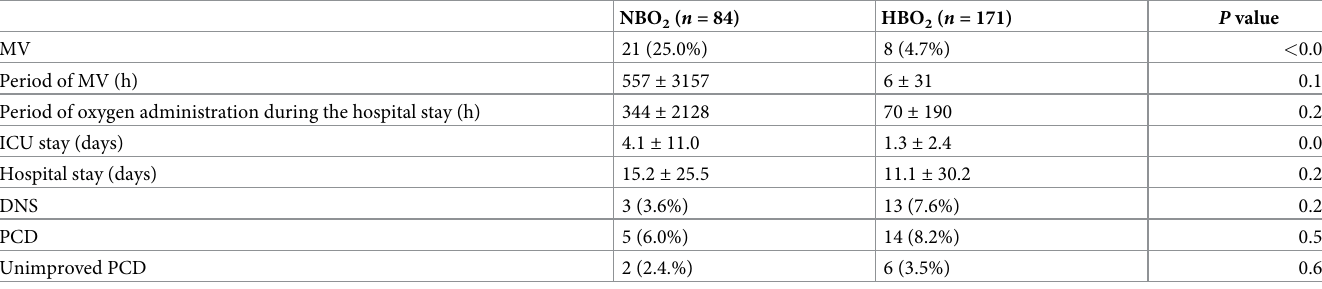
Table 3. Therapeutic periods and incidence of neurological